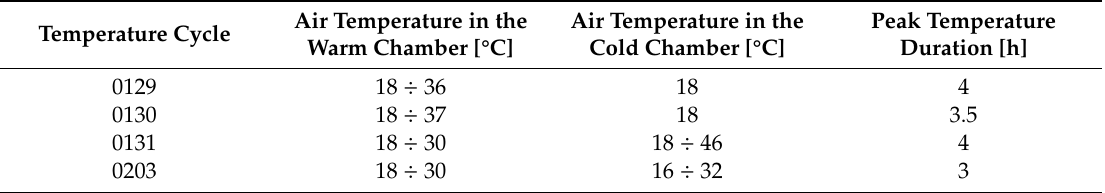
Table 1. Testing cycles of the boundary